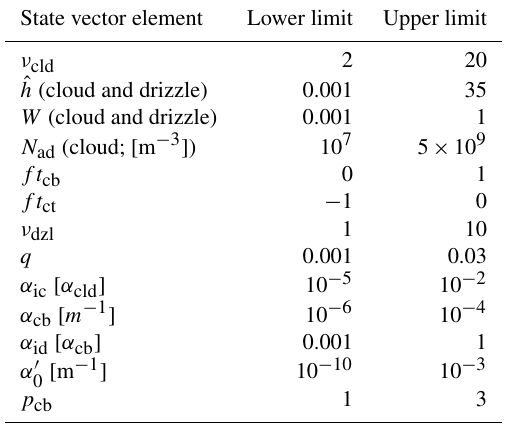
Table 1. Lower and upper bounds for the state vector values used in the optimization. The units, when relevant, are given in the square